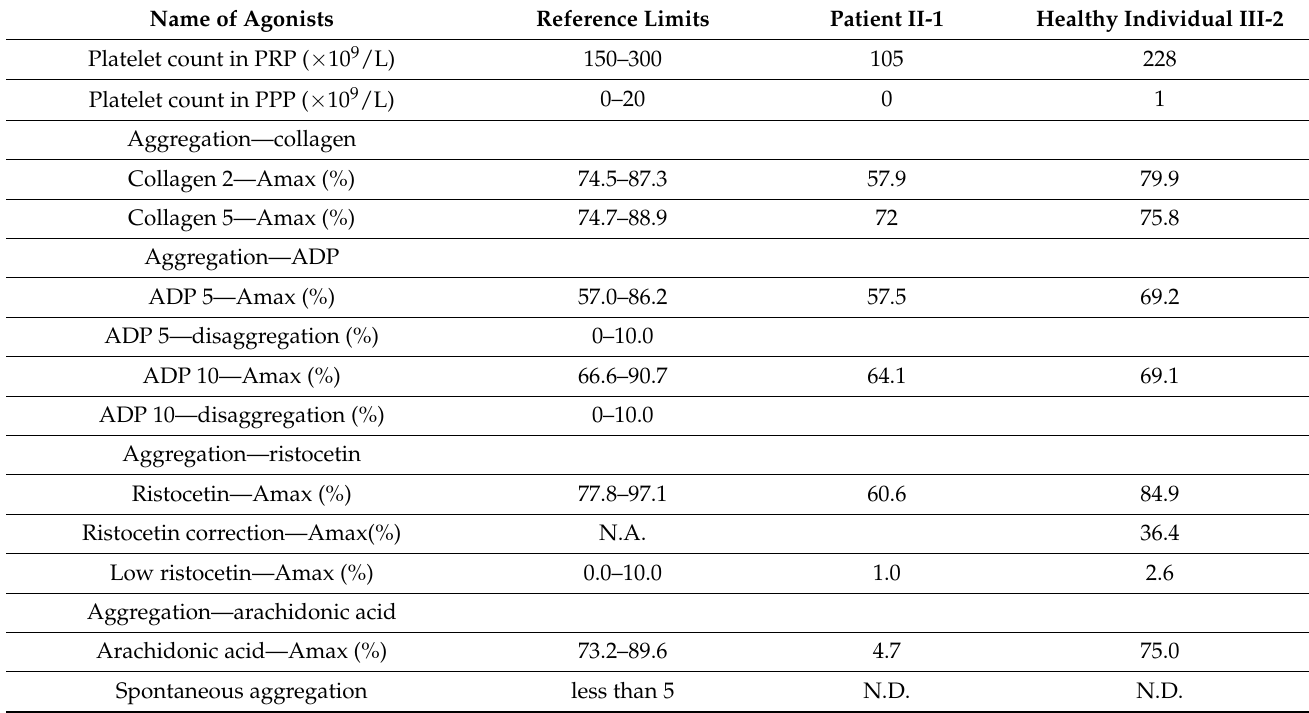
Table 1. The reference limits and maximum aggregation results in patient II-1 and healthy individual